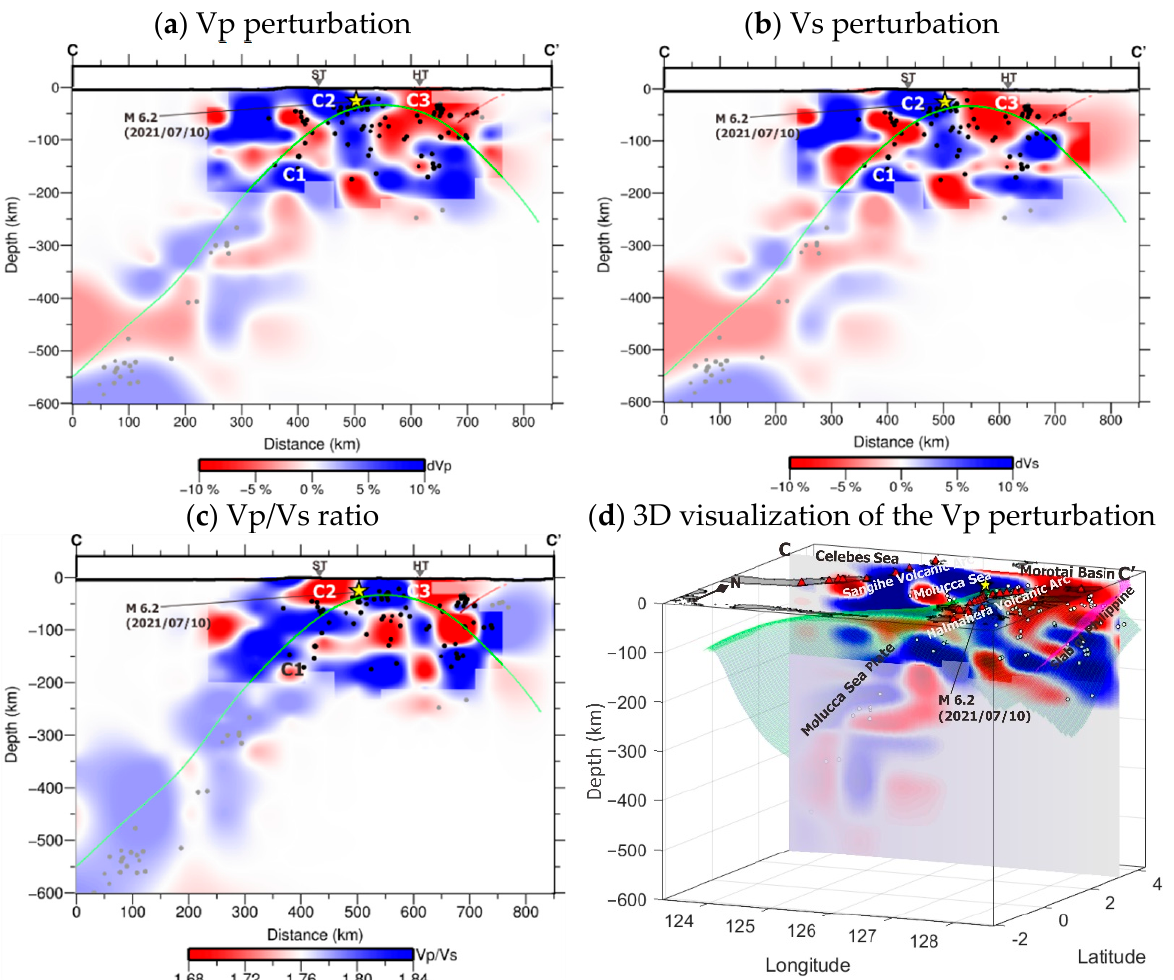
Figure 8. Vertical cross-section of C-C ′ (west–east) crossing the Celebes Sea, Sangihe Island, Molucca Sea, and Morotai Basin. The red color indicates low velocity and low Vp/Vs ratio. The blue color indicates high velocity and high Vp/Vs ratio. The C1, C2, and C3 are areas for the interpretation of tomographic inversion results. The black dots signify earthquakes within a radius of 30 km < C-C ′ < 30 km, and the yellow star is a significant earthquake. The green line and the green three-dimensional surface plot are the slab2 models of the Molucca Sea Plate, and the brown line is the slab2 model of the Philippines [45]. ST: Sangihe Trench; HT: Halmahera Trench; the blurred area is an area that is not well-resolved.